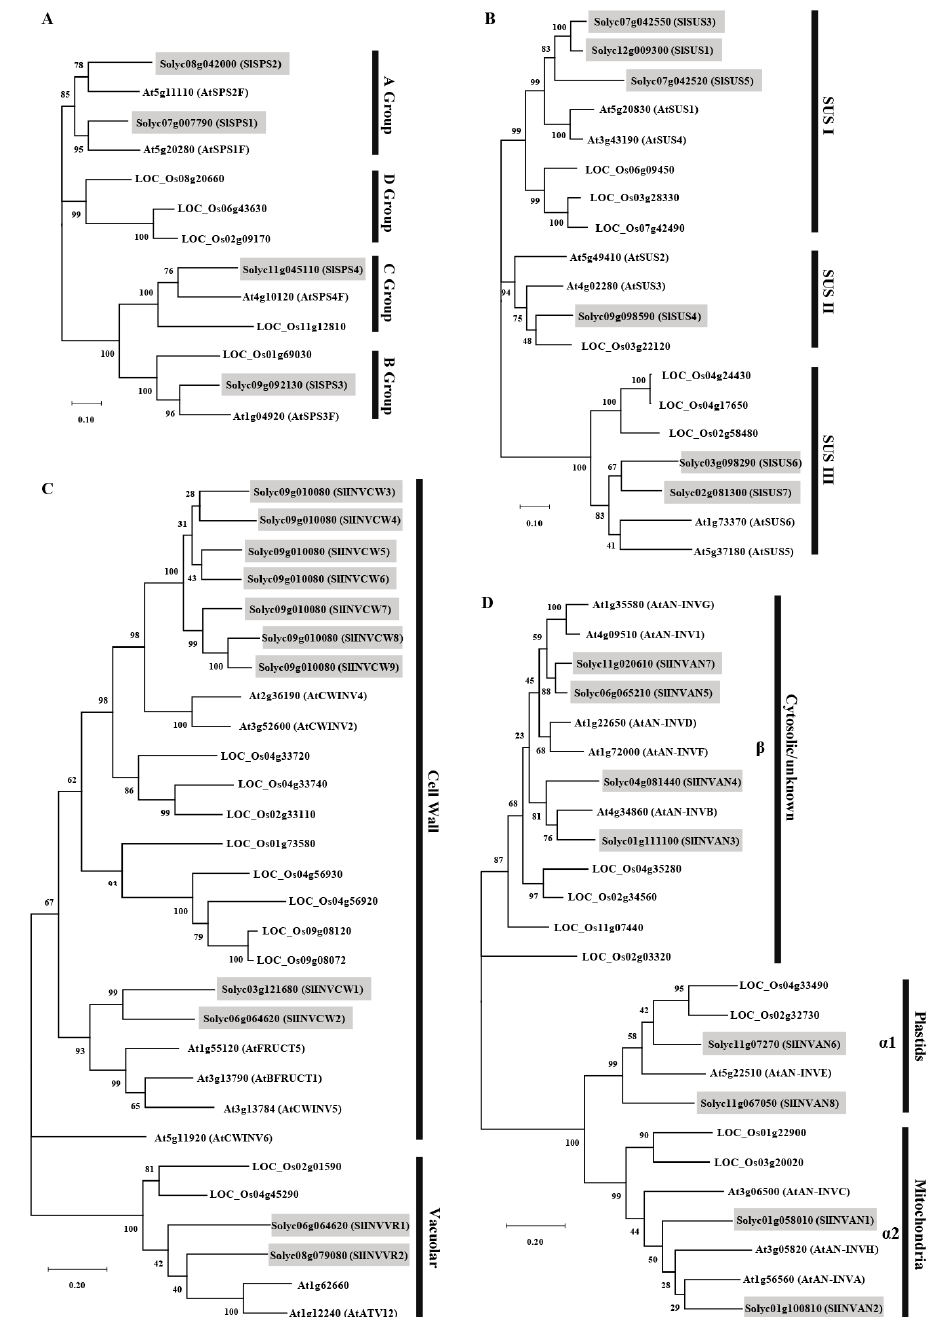
Figure 1. Phylogenetic analysis of SPS ( A ), SUS ( B ), acid INV proteins ( C ) and alkaline/neutral INV proteins ( D ). Trees were built using amino acid sequences from Arabidopsis thaliana , tomato ( Solanum lycopersicum ) and rice ( Oryza sativa ). The phylogenetic tree was constructed using the maximum likelihood method with